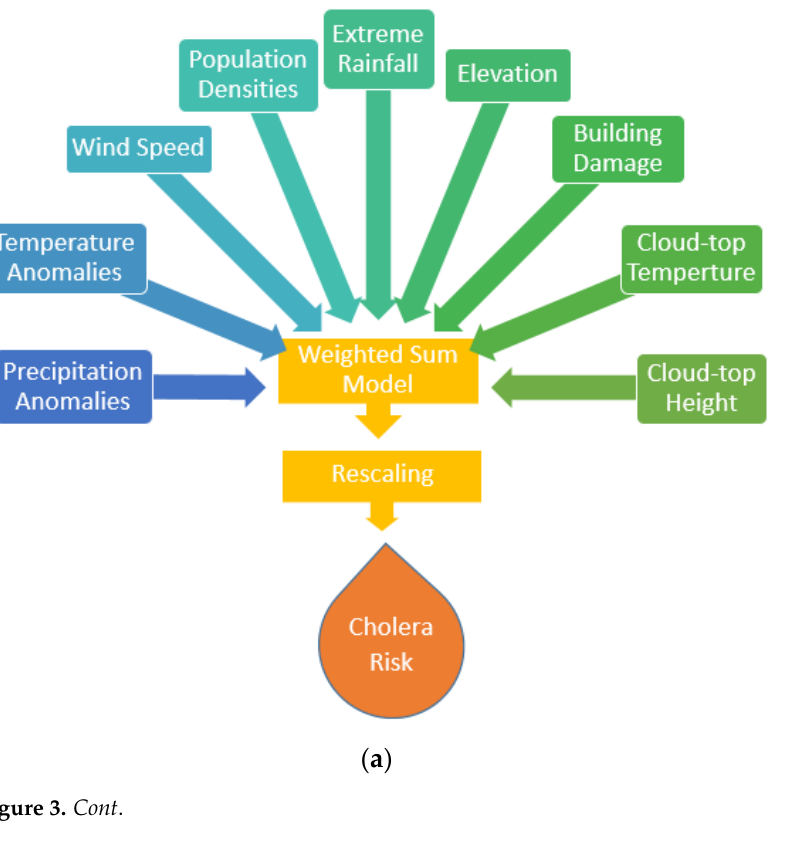
( b ) Figure 3. ( a ) Weighted sum model for cholera risk. ( b ) Relative feature importance for the XGBoost regression model for October. The machine learning approach was formulated as a regression problem, where the goal was to predict cholera risk on a per-commune basis for each month in the aftermath of Hurricane Matthew (October, November, and December 2016). Gradient-boosted trees